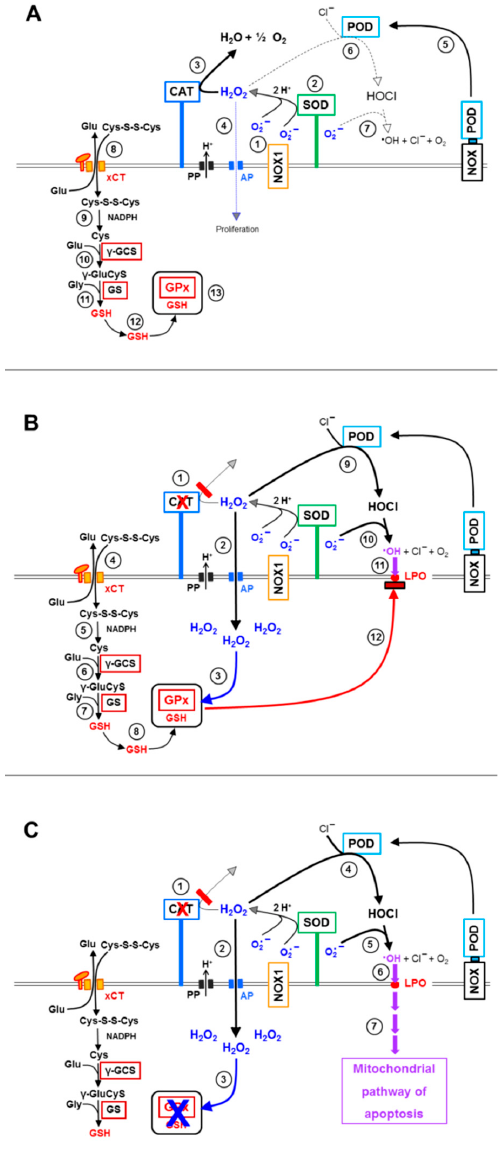
Figure 13. The interaction between membrane-associated catalase and aquaporins of tumor cells. ( A ). Catalase prevents HOCl signaling and influx of H 2 O 2 through aquaporins. NOX1-derived su- peroxide anions (#1) are dismutated by membrane-associated SOD (#2) or spontaneously. The re- sultant H 2 O 2 is decomposed by membrane-associated catalase (#3). A minor concentration of H 2 O 2 may escape the action of immobilized catalase and enter the tumor cells through aquaporins (AP) (#4). This is required for proliferation stimulation. Membrane-associated dual oxidase (DUOX) re- leases its peroxidase domain (POD) through the action of matrix metalloproteases (#5). As long as catalase is acting, the potential generation of HOCl through H 2 O 2 /POD interaction (#6), as well as hydroxyl radical generation through the reaction between HOCl and superoxide anions (#7) do not take place. The xC transporter transports cystine into the cells for the exchange of glutamate (#9). Cystine is reduced to L-cysteine (#9). Gamma-glutamylcyseine synthase combines L-cysteine and L-glutamate (#10) to γ glutamylcysteine ( γ -GluCys). Glutathione synthase then completes the formation of glutathione (GSH) (#11). Glutathione and Glutathione peroxidase (GPx) effectively